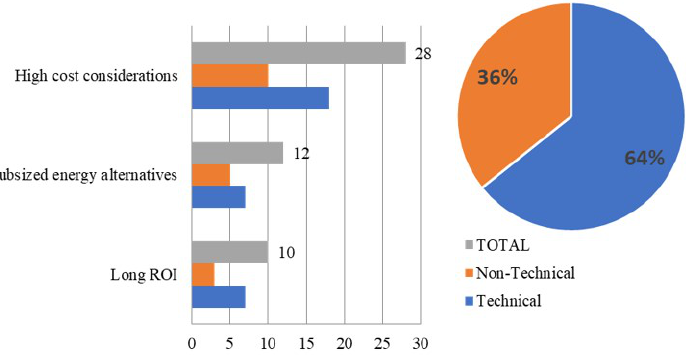
Figure 6. Economic barrier sub-themes with the number of participants who